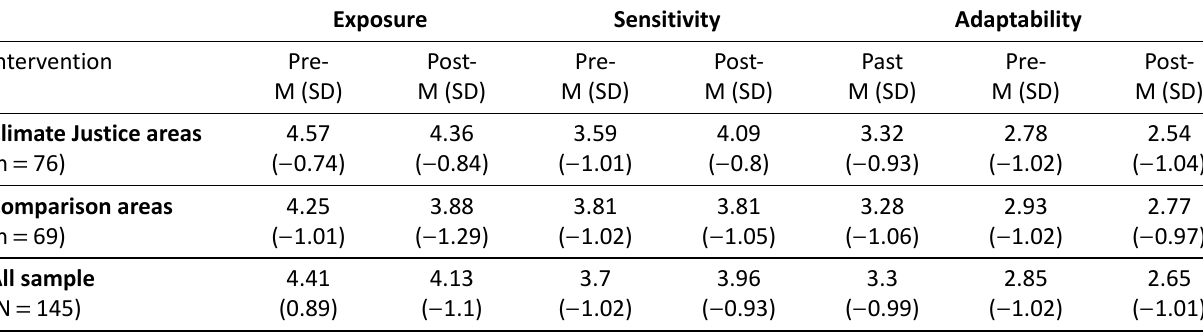
Table 4. Means and standard deviations for three dimensions of vulnerability for participants in climate justice and com- parison areas at pre- and